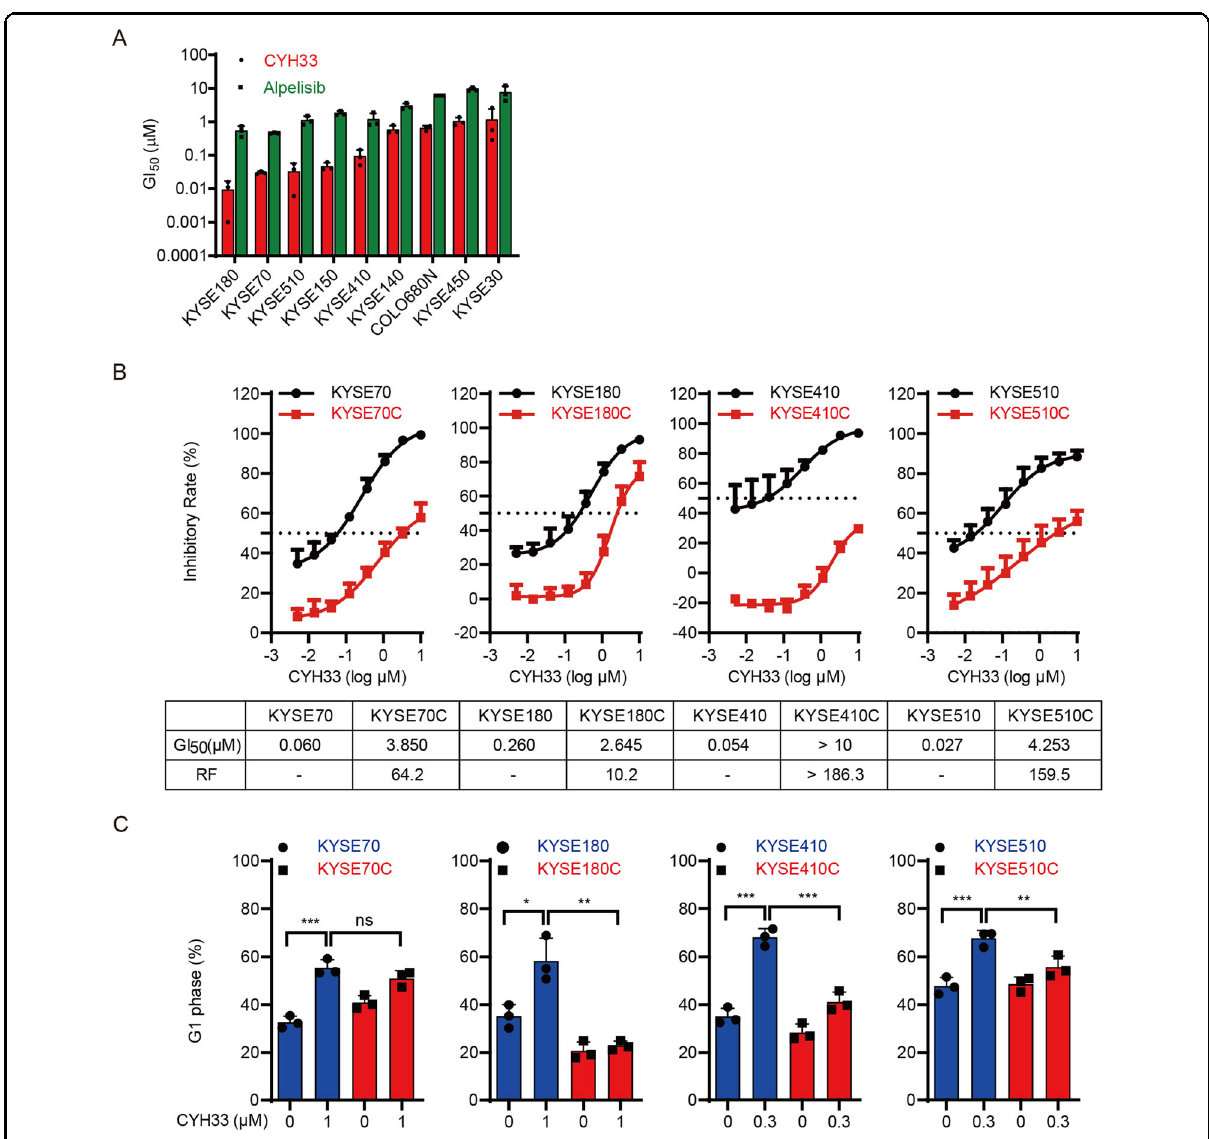
Fig. 1 ESCC cells developed acquired resistance after continuous exposure to PI3K α inhibition. A A series of ESCC cells were treated with CYH33 or alpelisib for 72 h and the GI 50 values were determined with SRB assay ( n = 3). B Parental and resistant cells were incubated with CYH33 for 72 h and cell proliferation was measured with SRB assay. Resistance factor (RF) was calculated by the ratio of GI 50 obtained in CYH33-resistant cells and that in parental cells ( n = 3). C Parental and resistant cells were treated with CYH33 at the indicated concentrations for 72 h and cell cycle distribution was analyzed by fl ow cytometry ( n = 3). Data are presented as mean + SD. Differences between indicated groups were analyzed using one-way ANOVA with Tukey multiple group comparison test.* P < 0.05, ** P < 0.01, *** P <